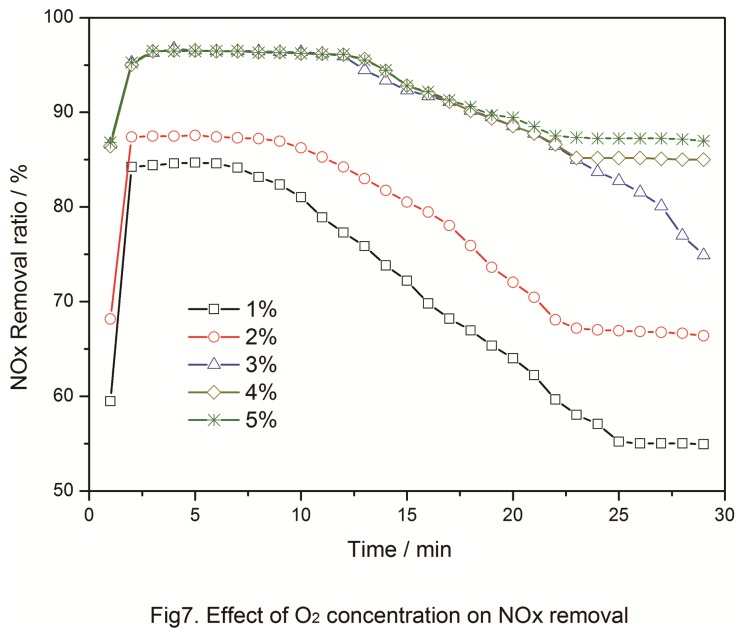
Effect of O2 Concentration on NOx removal.